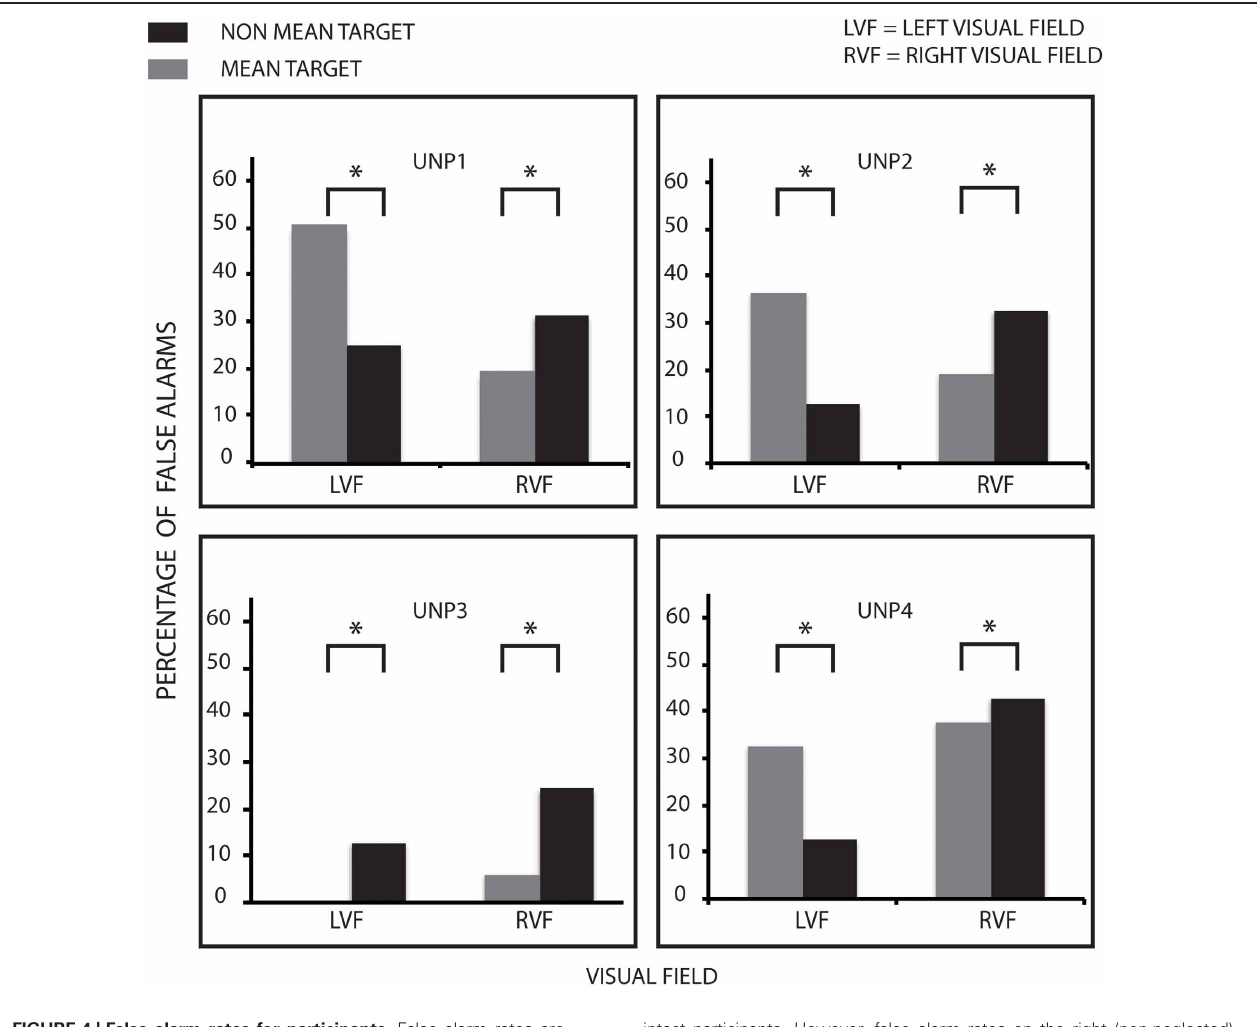
FIGURE 4 | False alarm rates for participants. False alarm rates are higher to the mean compared to the non-mean target on the left (neglected) side, mirroring the expected performance for neurologically